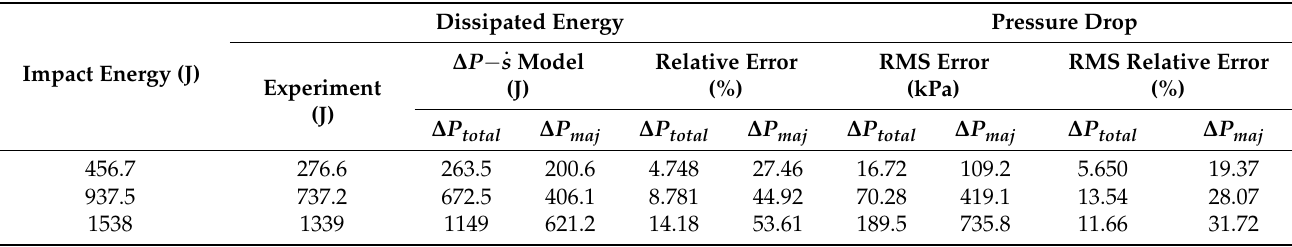
Table 2. Dissipated energy in MR shock absorber for impact energy; RMS values of error for model-based and measured pressure data over stroke velocity range of 0.1 m/s or more.